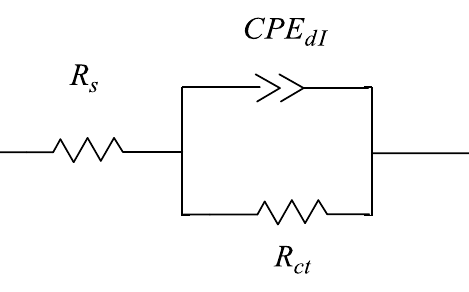
Figure 4. Equivalent circuit model used to fit the impedance data for mild